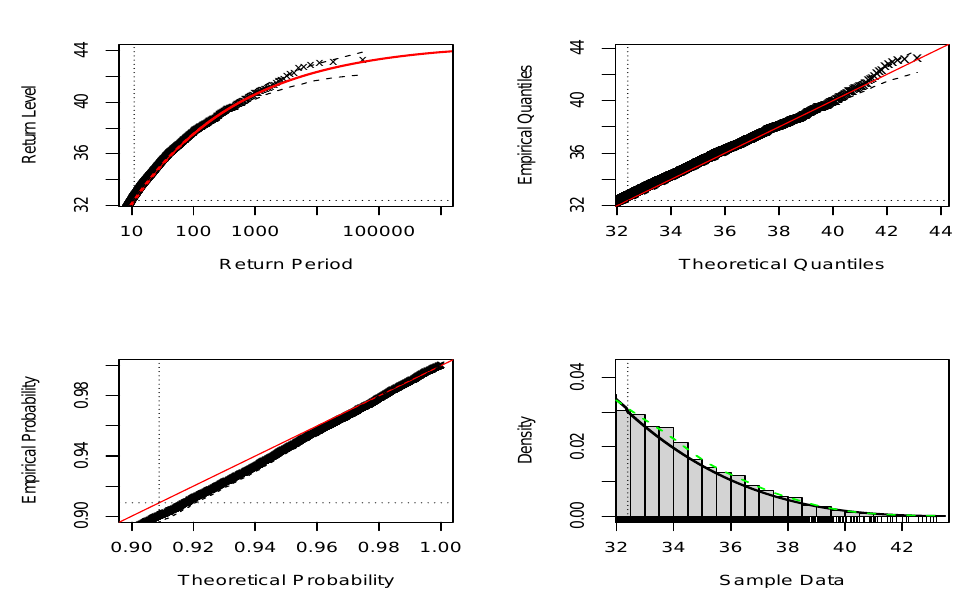
Figure A2. Diagnostic plots for fitted Bulk model of Temperature.